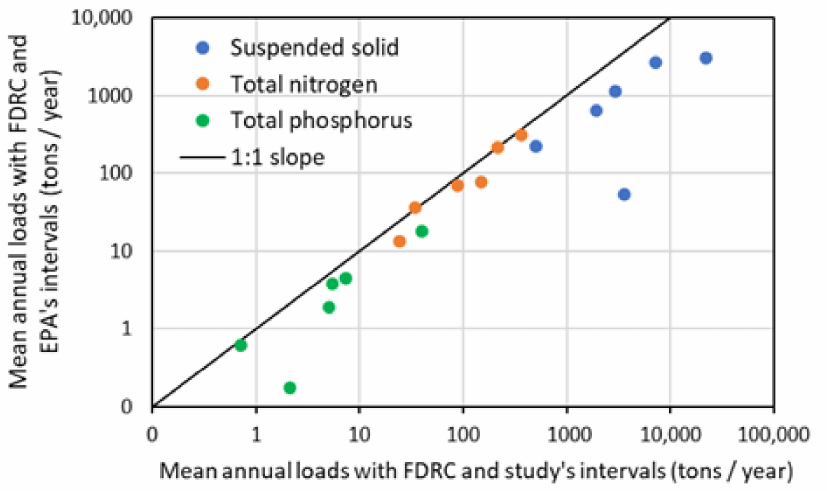
Figure 8. Comparison of the mean annual loads calculated with the FDRC method using the intervals proposed in the EPA approach (Figure 5) and those used in this study (Figure 6) (plotted on a log scale). In Mediterranean rivers, flows are very different during periods without floods (es- pecially low water) and in flood events. During floods, the concentrations of particulate elements are very strongly exacerbated. The FDRC method must therefore take into